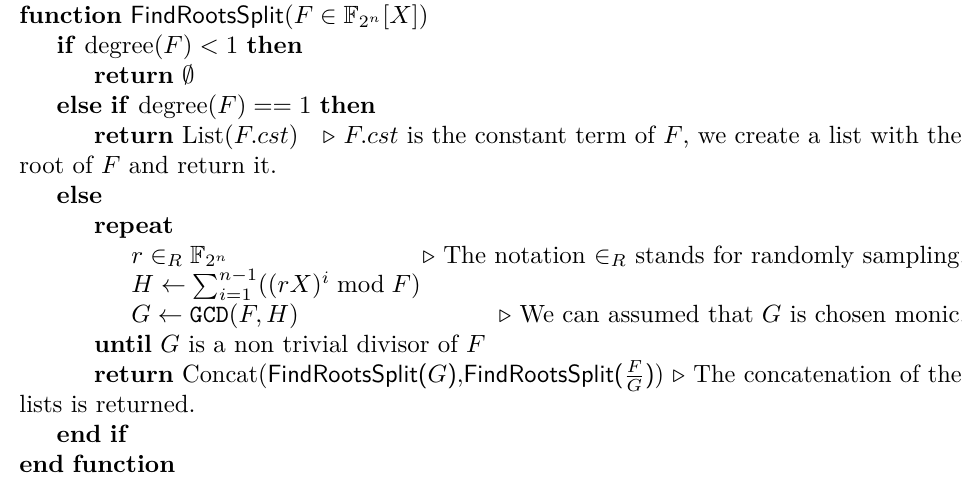
Algorithm 7 Algorithm to find the roots of a split monic univariate polynomial. function FindRootsSplit ( F ∈ F 2 n [ X ])